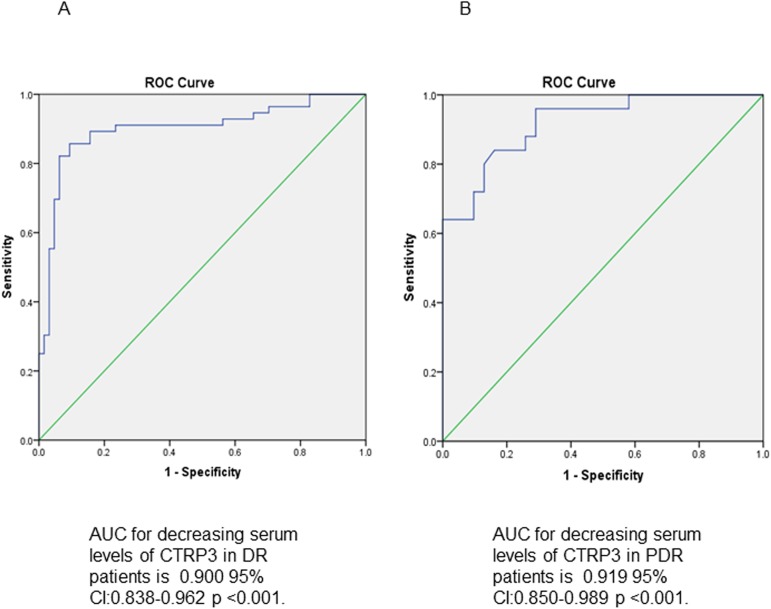
ROC curves, for DR/PDR diagnosis, by circulating CTRP3 level.(A) ROC curve analysis revealed that CTRP3 distinguishes patients with and without DR, AUC = 0.900 (95% CI 0.838–0.962, P<0.001). (B) CTRP3 distinguishes PDR from NPDR, AUC = 0.919 (95% CI 0.850–0.989, P<0.001).